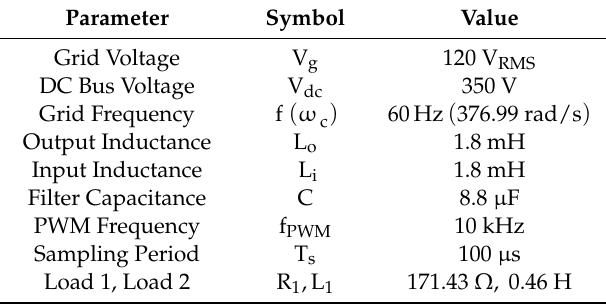
Figure 21. Islanded microgrid scheme with the RL loads. Table 2. Parameter specifications for the microgrid scenario.